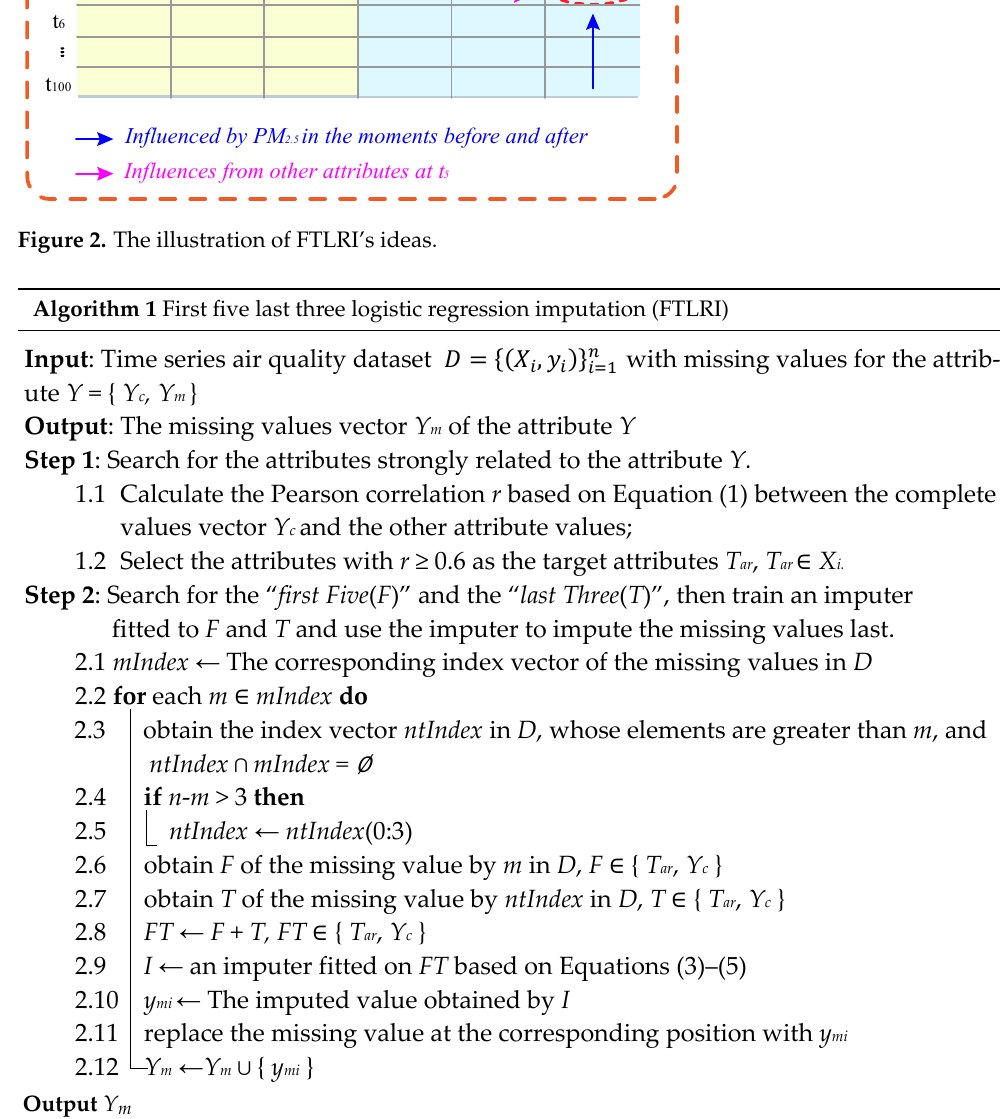
Figure 2. The illustration of FTLRI’s ideas.